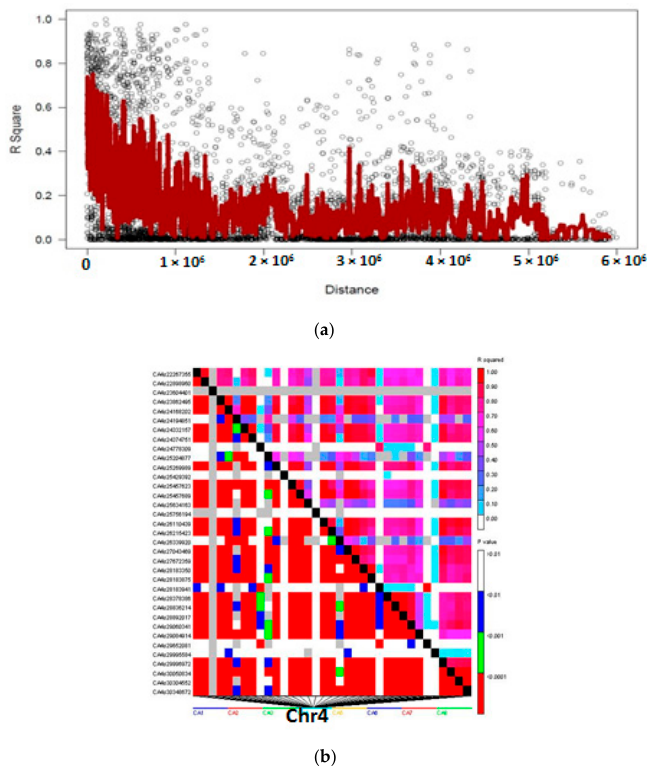
Figure 8. Linkage disequilibrium (LD)-measured r 2 plotted vs. the physical map (bp) between pairs of DArTseq-SNP markers in a panel of 186 chickpea genotypes ( a ), which show the huge LD decay on Chr4 ( b ).